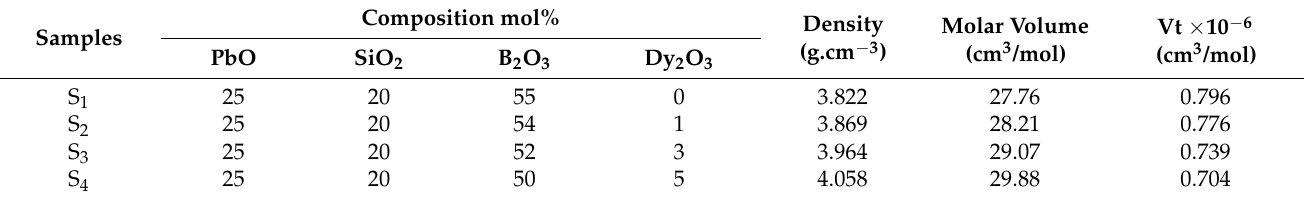
Table 1. Glass compositions, density, molar volume, and concentration of Dy 3+ of 0.25